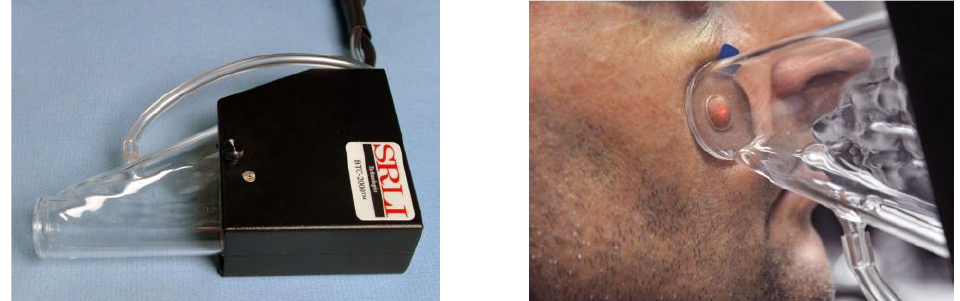
Figure 1. Left : Glass chamber used to create vacuum and measure displacement with skin or elastomer. Right : Vacuum applied to facial skin, with displacement measured by movement of laser target, which is seen as a red dot in the center of displaced skin.